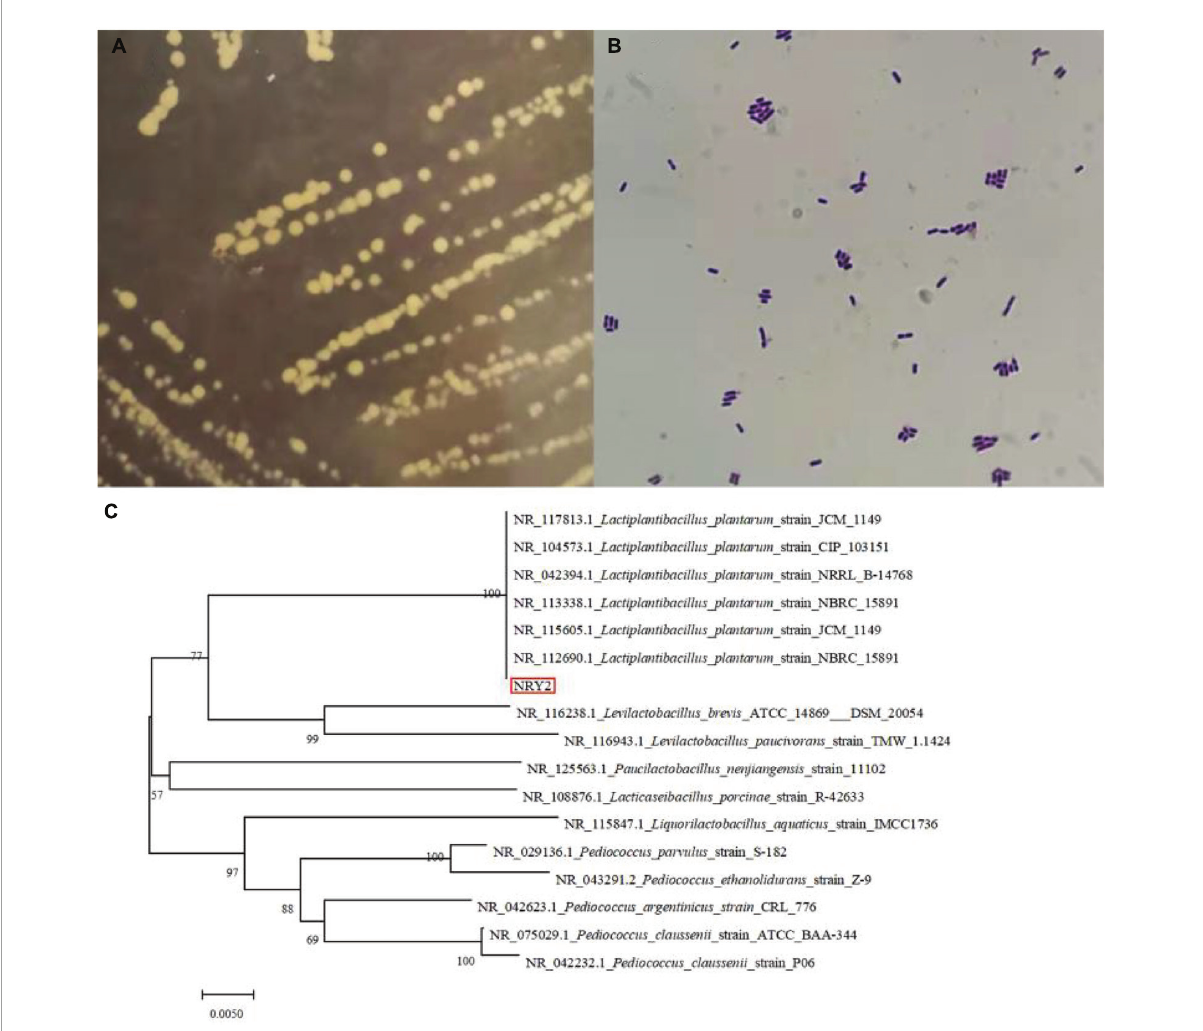
FIGURE1 The colonial morphology ( A , MRS plate), gram staining picture (B) and colonial morphology the hylogenetic tree (C) of Lactobacillus plantarum